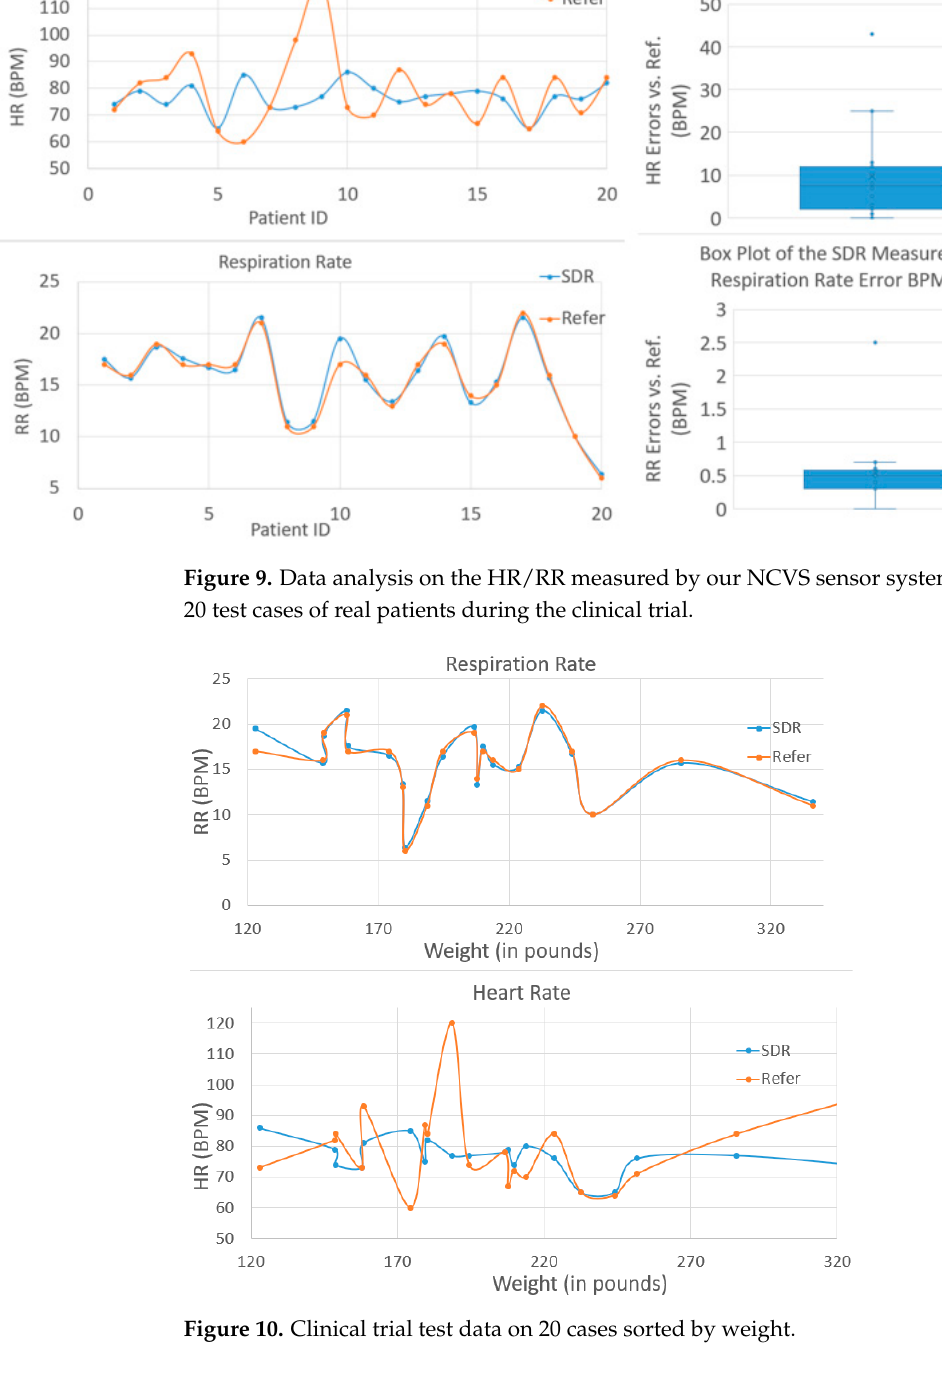
Figure 11. NCVS clinical trial test data on 20 cases sorted by height.